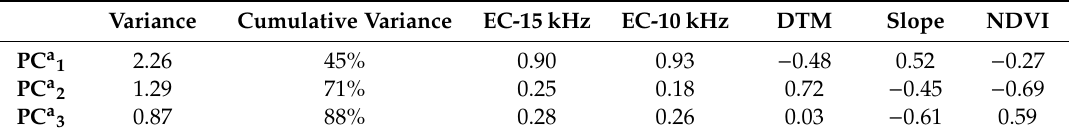
Table 6. Results of PCA applied in the area ‘a’: variance of the principal components considered in CA and correlation coe ffi cients with the variables used to delineate SSMZ.